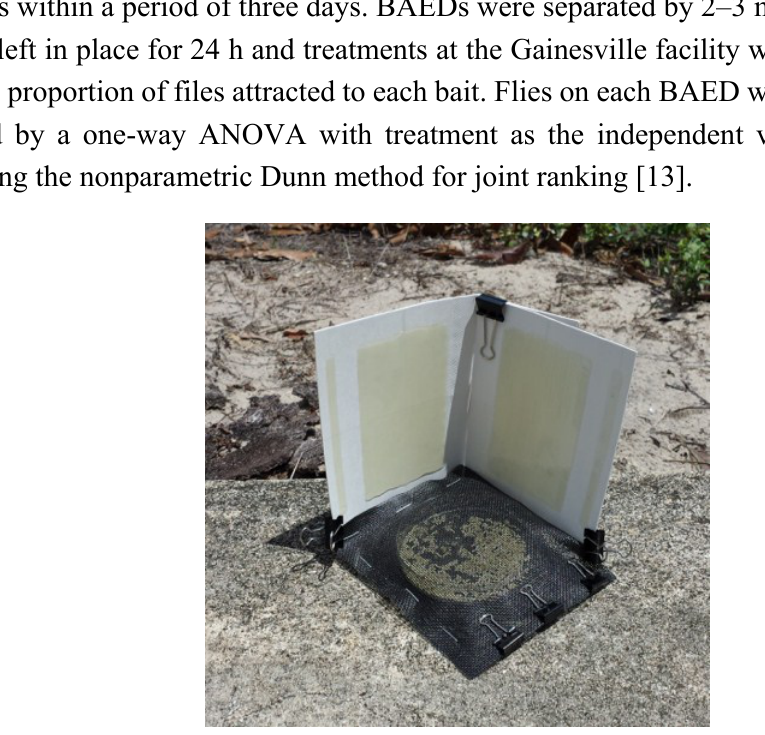
Figure 1. Field baited attraction evaluation